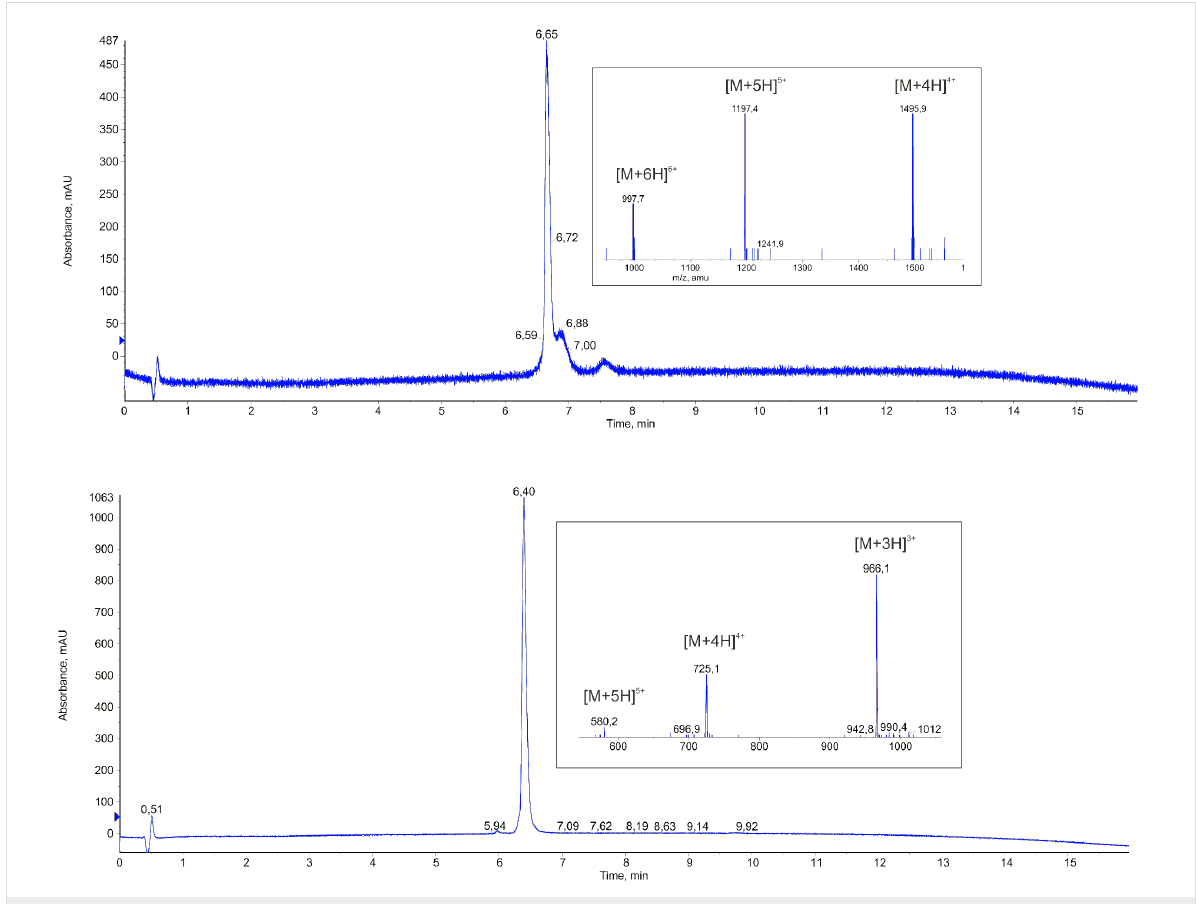
Figure 2: HPLC chromatograms and ion masses from the ESI-mass spectra (insets) of purified CD4-M2 (M = 5979.83, top) and CD4-M5 (M = 2896.4, bottom).